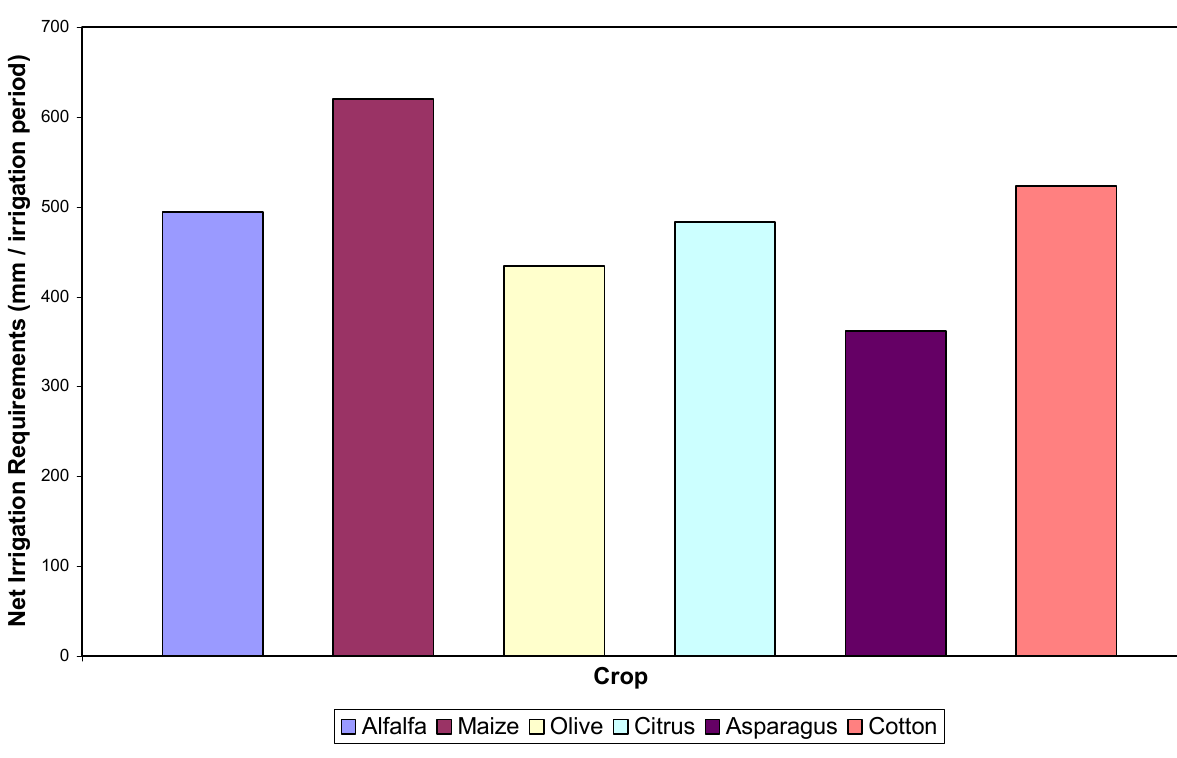
Figure 6. Net Irrigation Requirements for crops in Aitolikon